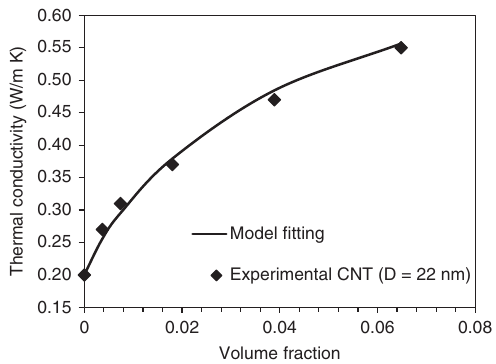
Figure 1: The thermal conductivity experimental data along with thermal conductivity fitted by Krenchel Equation (Equation 9), average diameter of MWCNT = 22 nm.